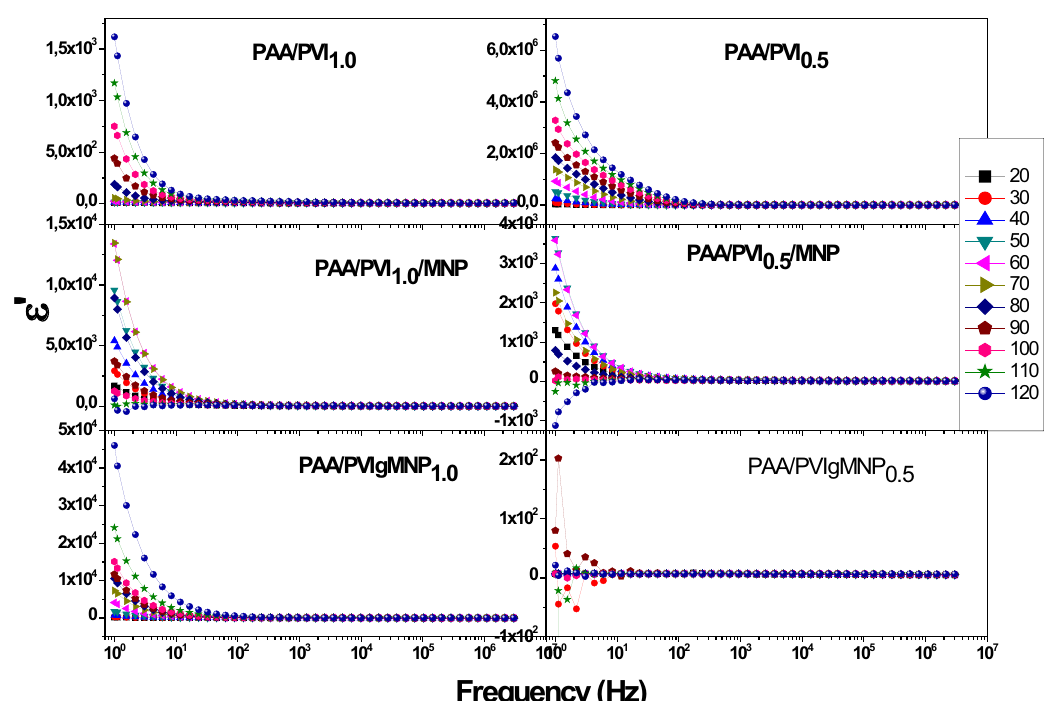
Figure 8. Real part of Permittivity of A) PE1 B) PE2 C) NPE-1 D) NPE-2 E) NPE-3 F) NPE-4 as a function of frequency at various temperatures.